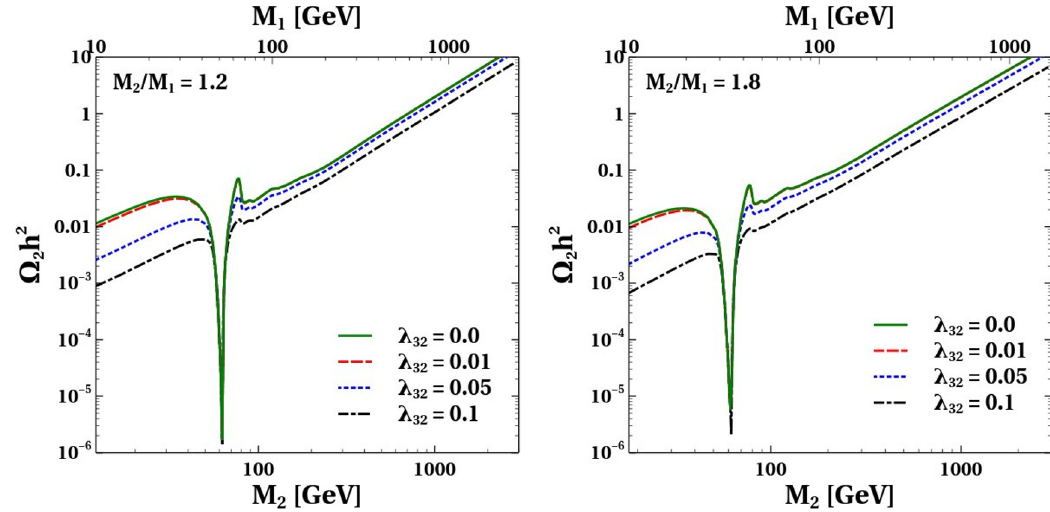
Figure 4 . The e(cid:11)ect of (cid:21) 32 on (cid:10) 2 for two di(cid:11)erent values of M 2 =M 1 : 1 : 2 (left panel) and 1 : 8 (right